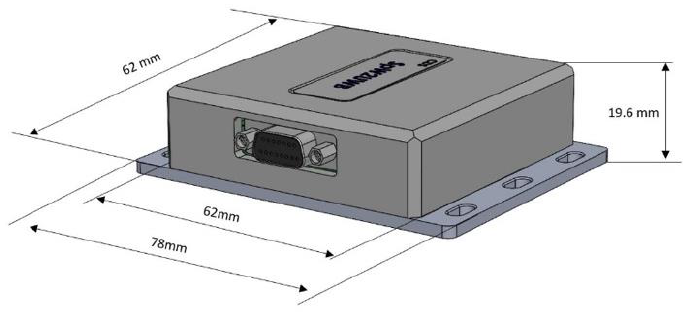
Figure 4. Enclosure dimensions. Figure 4. Enclosure